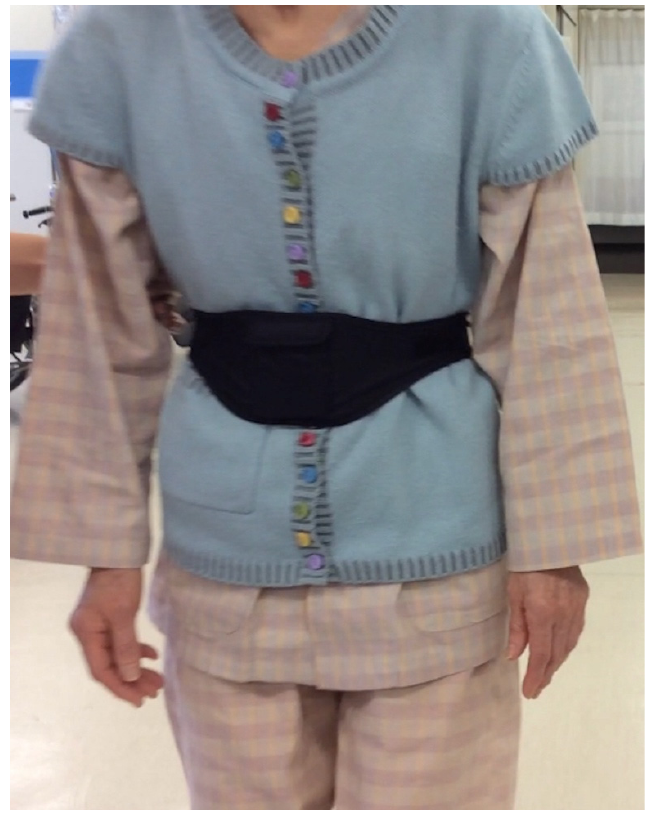
Figure 2. The device was secured at the center of subjects’ waists using a Velcro